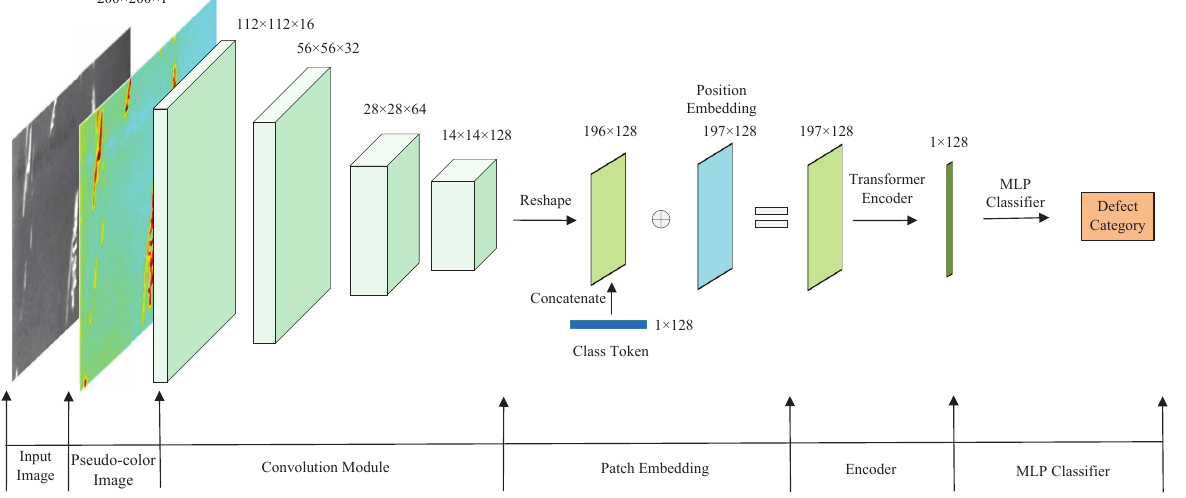
Figure 4. CNN-T workflow. The numbers on the label respectively indicate the height, width, and channels of the feature map.